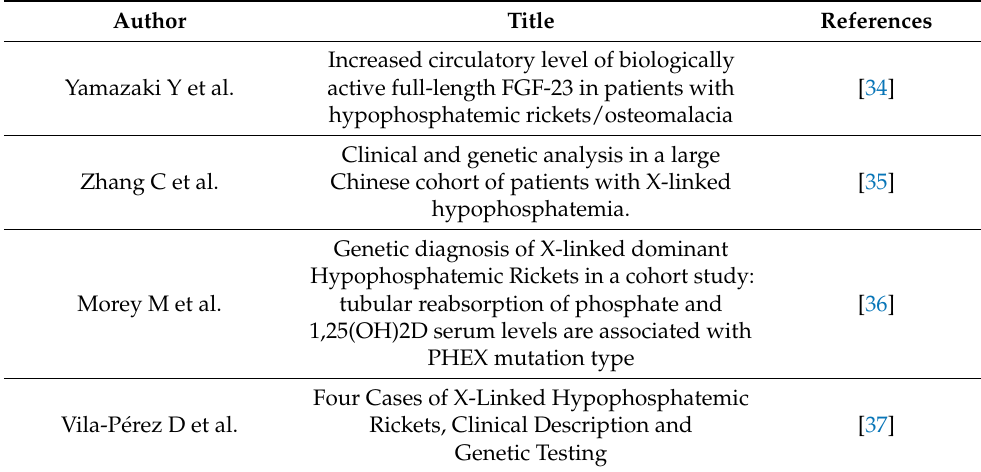
Table 4. The c.565C > T (p.Gln189Ter) mutation in